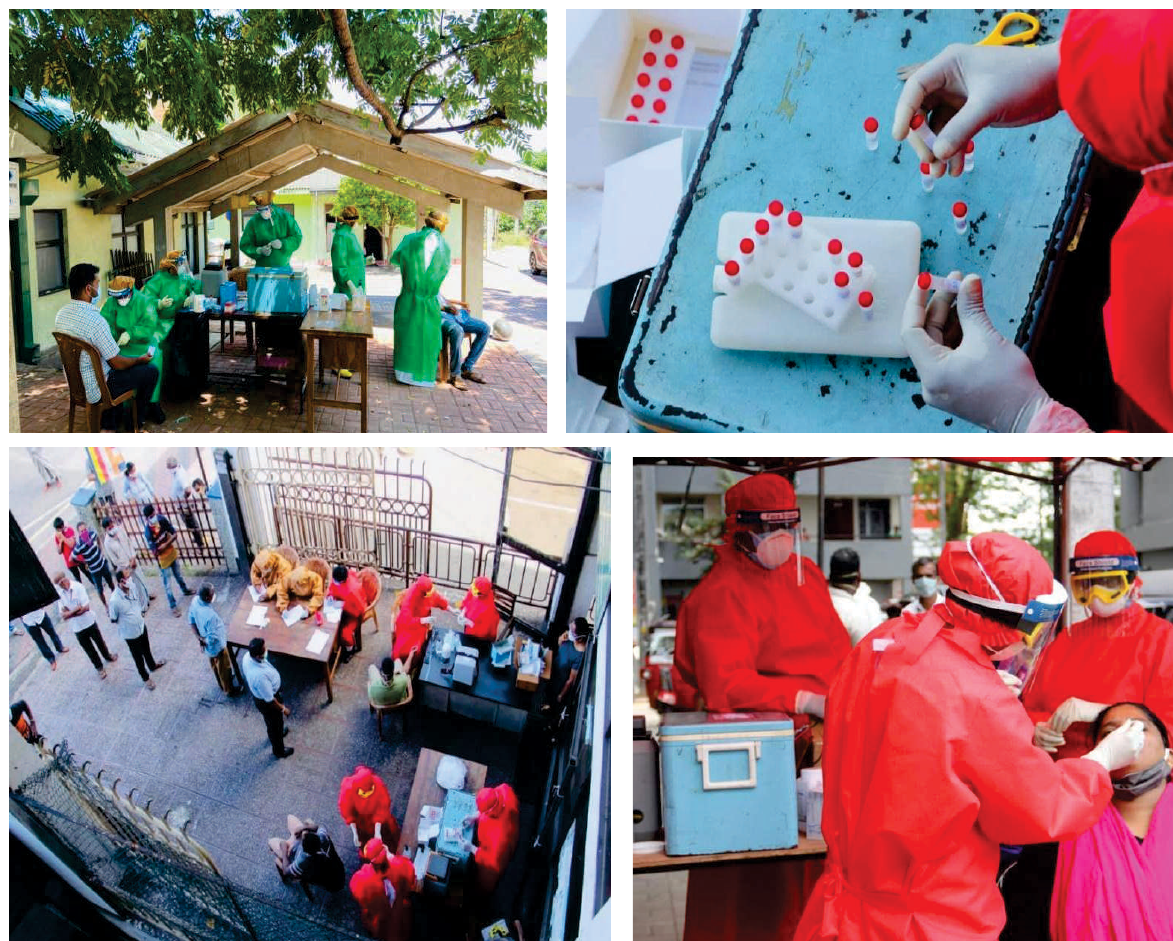
Figure 2: Sample collection for PCR and antibody testing in the City of